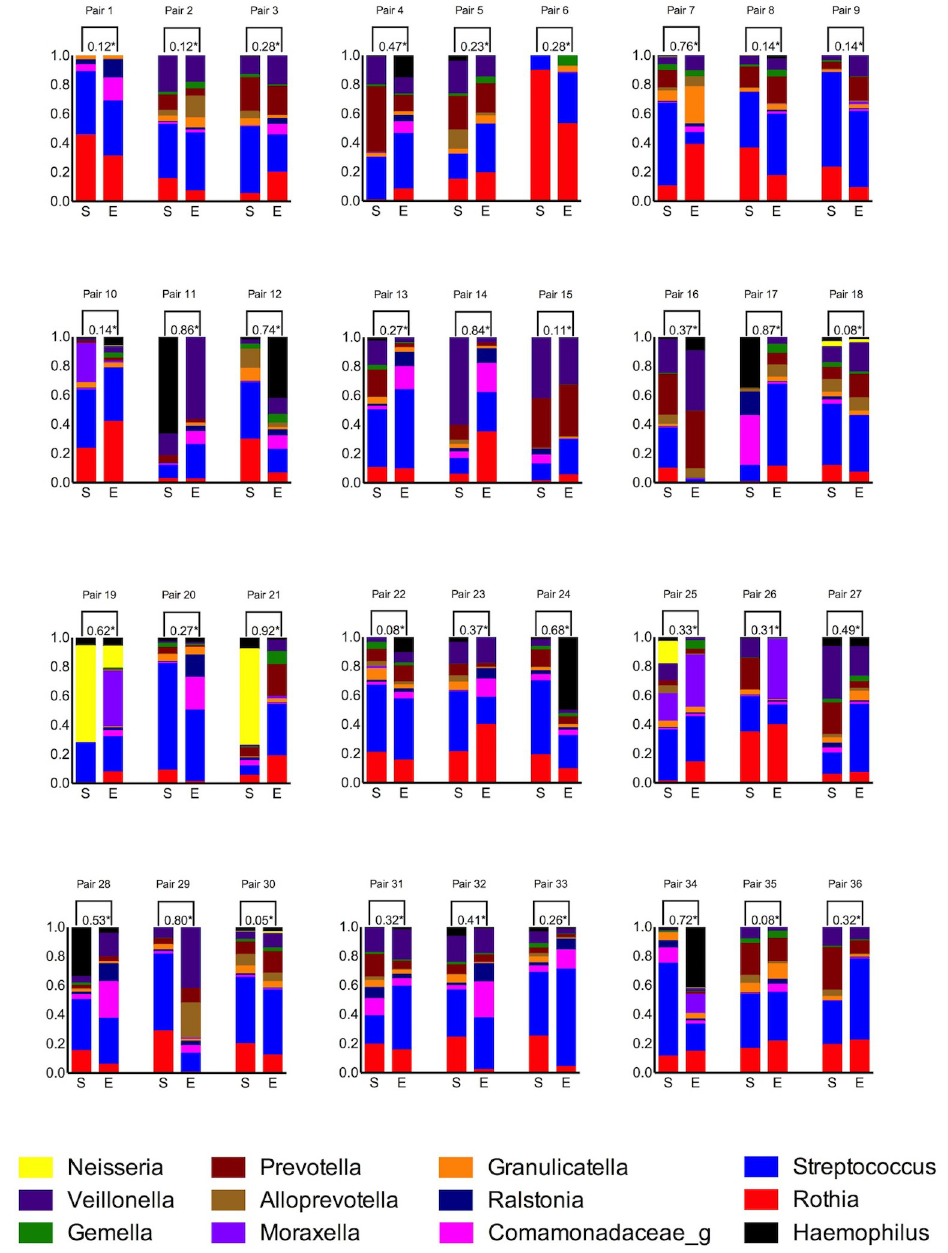
Fig 4. Comparison of bacterial composition in pairs of induced sputum samples (stable state and exacerbation) from 36 patients suffering from chronic obstructive lung disease. Presenting level 6 taxonomy (genus) provided by Silva database for amplicon sequence variants containing at least 1% of all sequences. � Yue-Clayton dissimilarity (1- θ YC ) Range 0 to 1; 0 = perfect similarity, 1 = perfect dissimilarity. S: Stable state E: Exacerbation. Changes in Faith’s PD by disease state were not related to levels of white blood cell counts (WBC) or absolute neutrophil counts (ANC), while Shannon’s non-PD was lower at stable state among patients whose ANC did not become elevated during exacerbations (Kruskal Wal- lis, p = 0.04) (Fig 6B).